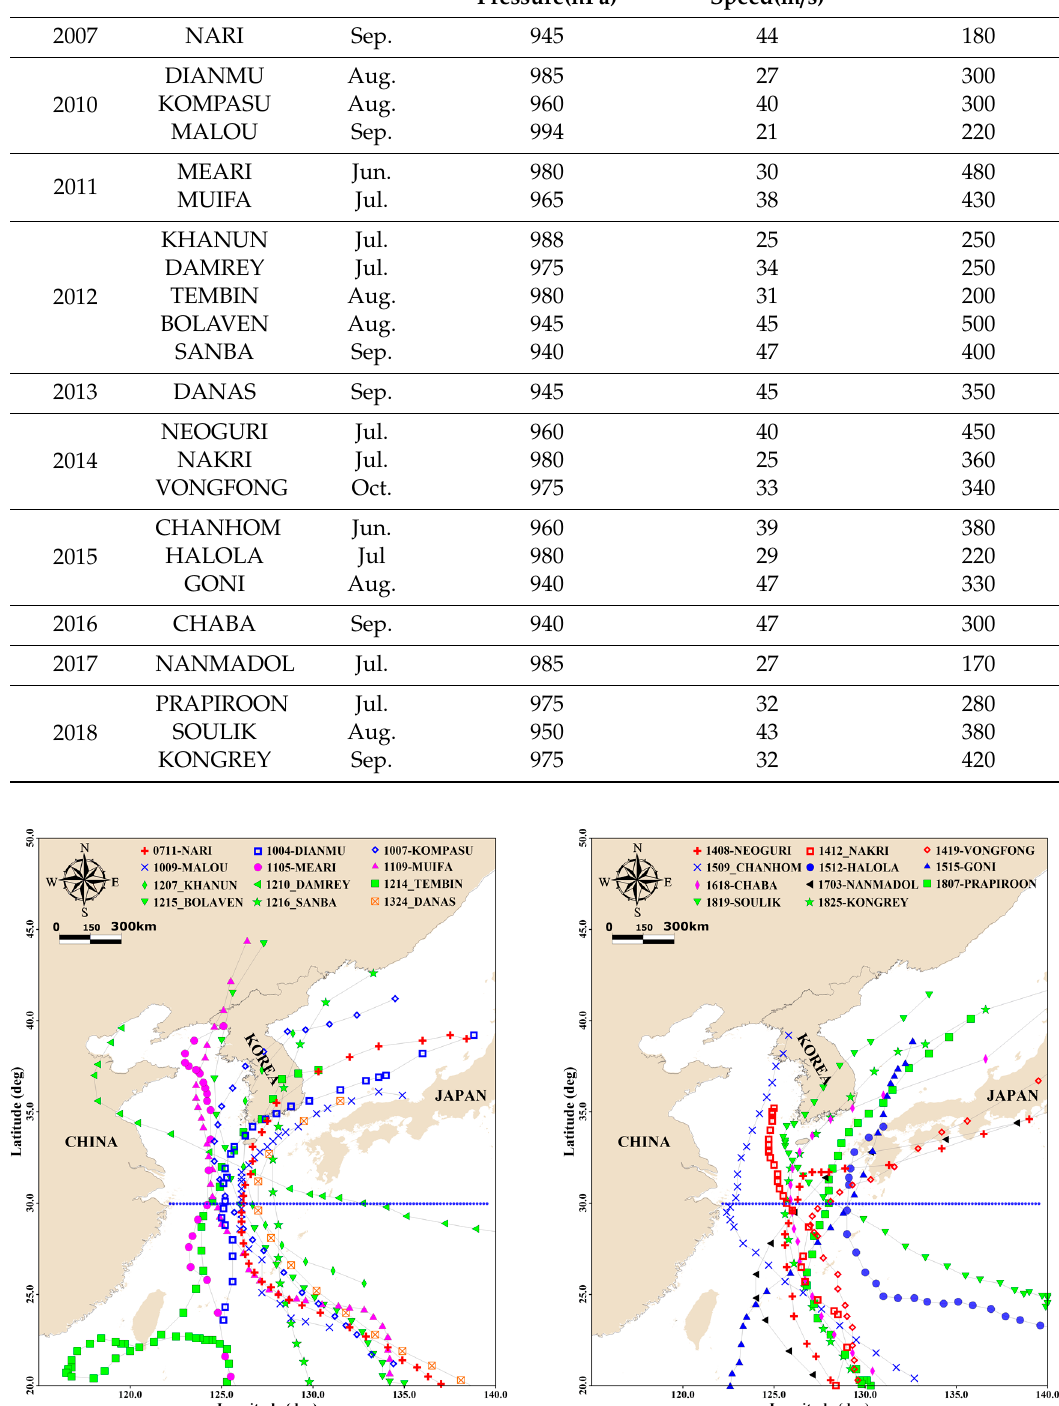
Figure 18. Measured and computed time series of significant wave heights among the three wind fields during Typhoons GONI (2015) and CHABA (2016). 5. Discussion In this study, the SWAN wave model is employed for hindcasting. In reality, other wave models, such as WAM (wave model), can be used for similar purposes. For example, Kim et al. [10] used the HYPA and WAM for hindcasting in the seas around the Korean Peninsula. Their research motivated the present study. The SWAN model has been widely employed in hindcasting in other oceans and seas [1,3,4,6,7,8,9] but not in the seas around the Korean Peninsula. Apparently, it would be